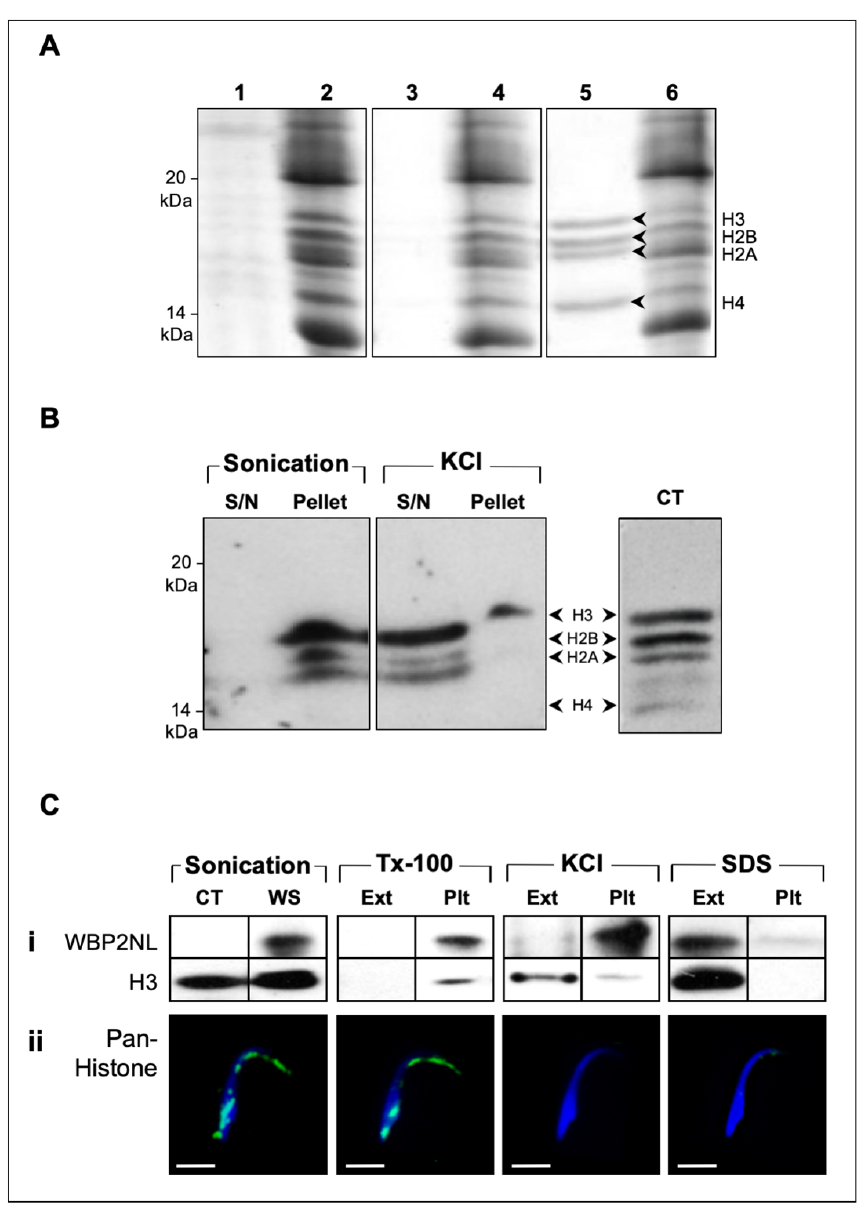
Figure 4. SDS-PAGE, immunoblot and immunofluorescence analyses of protein extracts from whole rat spermatozoa: ( A ) Coomassie-stained, 16.5% gel displaying four prominent protein bands extracted from rat whole sperm by mild sonication in 1 M KCl (lane 5), with corresponding profiles of solubilized sperm pellet before and after high-salt extraction (lane 6); conversely, these bands were not visible in Triton X-100 (lane 1) or sonicated (lane 3) extracts of rat whole sperm relative to corresponding pellets (lanes 2 and 4, respectively); ( B ) immunoblot probed with anti-pan histone antibody revealed consistent labeling patterns between calf thymus-derived histones (CT) and 1 M KCl extract of whole rat sperm; minimal labeling was detected in the KCl pellet following high-salt extraction, only a remnant of H3 band was discernable (s/n, supernatant); ( C ) ( i) immunoblots of sperm extractions in 2% Triton-X100, 1 M KCl, and 2% SDS probed with an affinity-purified H3 antibody to confirm histone extractability and an anti-WBP2NL/PAWP antibody to assess perinuclear theca extraction selectivity; (ii) sperm extracts from each extraction pellet were also analyzed by indirect immunofluorescence using an anti-pan histone antibody to examine the efficiency of each extraction and the integrity of the head shape after each treatment. CT, calf thymus-derived histones; WS, whole sperm; Ext, extract; Plt, pellet. White bar = 5 μ m.